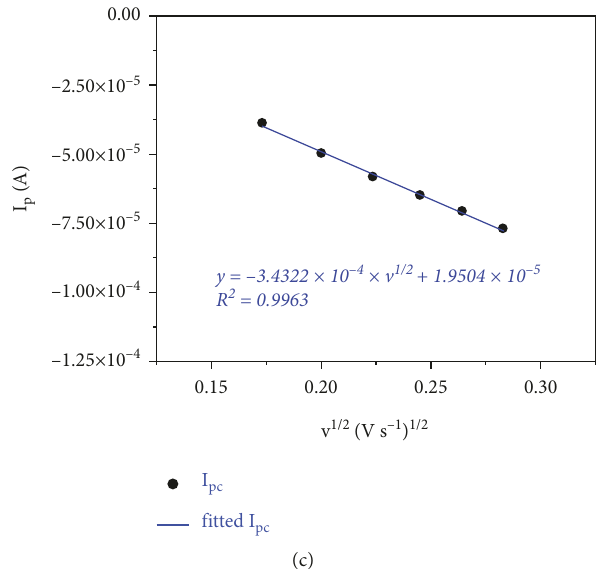
Figure 3: (a) CV results of the Pt/PANi NW electrode recorded in K 3 Fe(CN) 6 /K 4 Fe(CN) 6 (0.005 M) and 0.1M KCl solution, at the potential scan rates of 30, 40, 50, 60, 70, and 80mVs − 1 ; (b) the relationships between the anodic and cathodic peak potentials and ln v and their corresponding linear fit lines: E pa , the green line with square symbols, and E pc , the red line with star symbols; and (c) the relationship between the cathodic peak current ( I pc ) and the square root of the scan rate ( v 1/2 ) and its corresponding linear fit